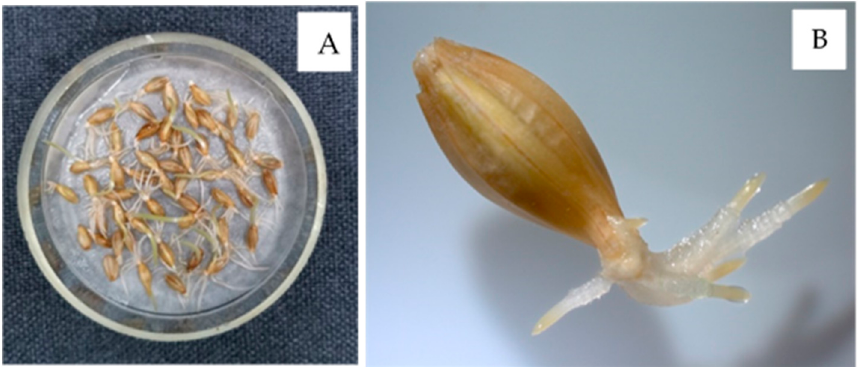
Figure 3. Photographs of Hordeum vulgare seeds: ( A ) A sample of seeds of the Hordeum vulgare L. culture treated with Se nanoparticles in a petri dish; ( B ) a single germinated barley seed.